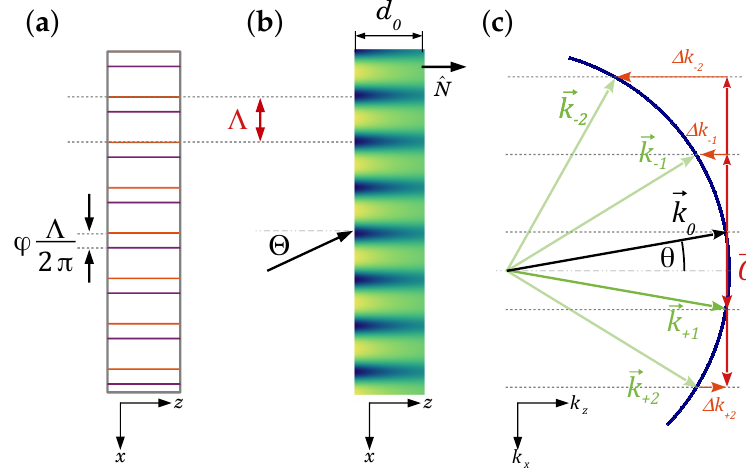
Figure 8. ( a ) Schematic for 2BC from mixed gratings with a phase shift ϕ . Orange and purple lines denote the maxima of the refractive index and the absorption grating, respectively (cf. Equations (3) and (4)). ( b ) Diffraction geometry of a one-dimensional in-plane ( ˆ N ∈ plane of incidence) grating with attenuation along the depth z . Λ = 2 π / G is the grating spacing; the incident wavevector reads (cid:126) q = 2 π / λ ( sin Θ ,0,cos Θ ) , where λ is the wavelength of the light in free space and Θ the angle of incidence outside the medium. ˆ N is the sample surface normal. ( c ) Diffraction geometry in reciprocal space. The grating vector is (cid:126) G = ( G ,0,0 ) ; (cid:126) k s is the real part of the wavevector of the s -th order diffracted beam in the medium, and thus, | (cid:126) k s | = 2 π n (cid:48) / λ , as well as sin Θ = n (cid:48) sin θ . ∆ k s is the corresponding 0 0 momentum mismatch when the Bragg condition is not fulfilled. Here, five-wave coupling is shown in the case that the Bragg condition is obeyed for the +1st order; the blue circle indicates the Ewald